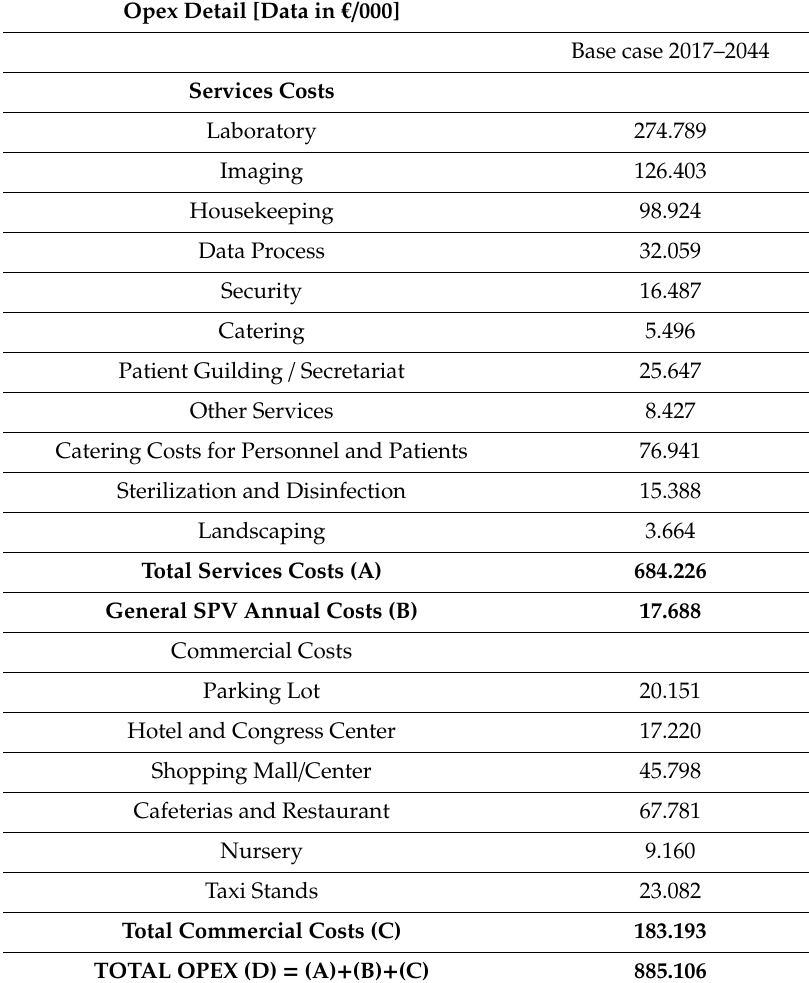
Table 3. Opex detail (data in € / 000).